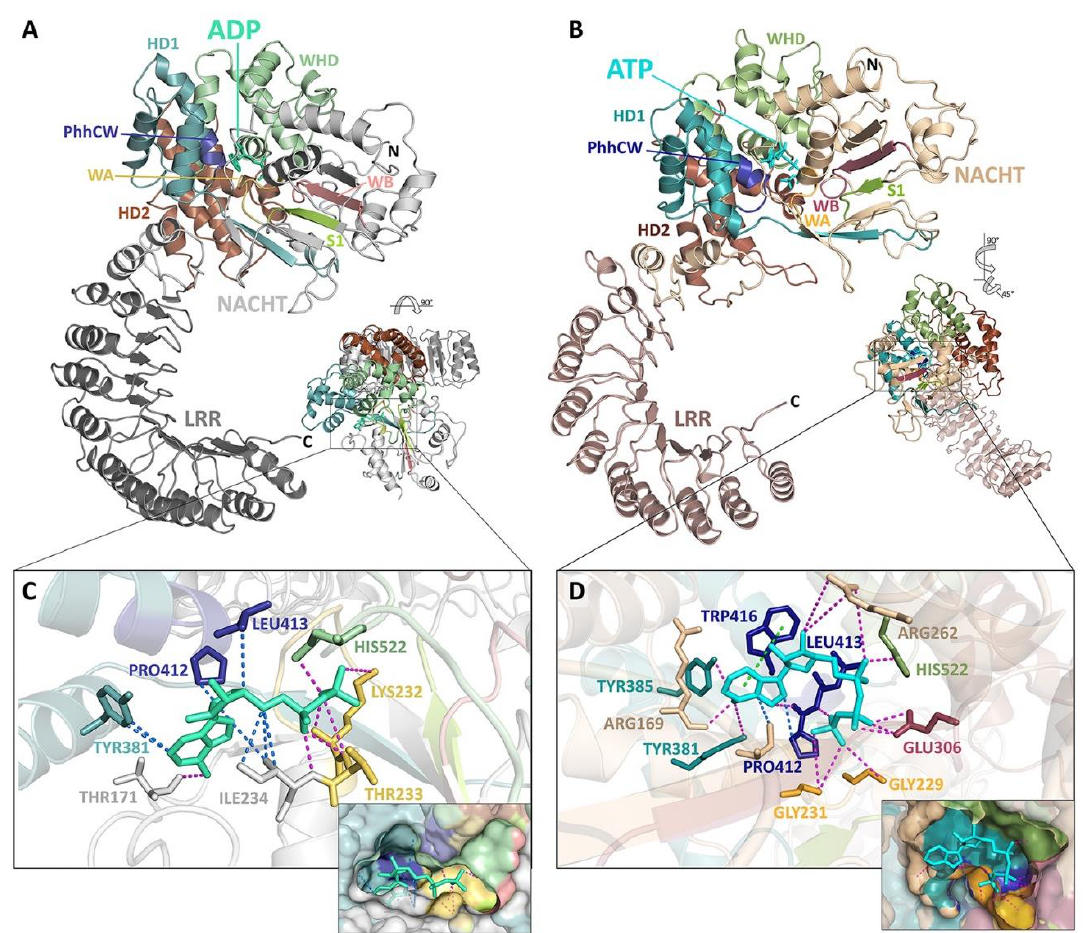
Figure 2. Molecular dynamic simulations of NLRP3 support distinctions in nucleotide-binding domain structure with occupancy of ATP or ADP ligands. ( A ) Ribbon diagrams in two orientations of the NLRP3-ADP structure (PDB: 6NPY). Domains are colour-coded and labelled following visual rendering with PyMOL v2.4 (pymol.org). The bound ADP ligand is shown in stick rendering. ( B ) Ribbon diagrams in two orientations of a representative ATP-bound structure provided with a 10 ns molecular dynamics simulation run with ATP occupancy of the NLRP3 structure (provided by PDB: 6NPY). Domains are colour-coded and labelled, and the bound ATP is shown with stick rendering. The detailed interactions for specific main chain and side chain residues are shown for NLRP3 and ADP ( C ) determined using the 6NPY structure, or NLRP3 and ATP ( D ) determined by molecular dynamic simulation. Insets: magnified ligand pocket surface views of the nucleotide-binding domain showing the motifs involved in coordination of the ADP (C) or ATP (D) ligands.